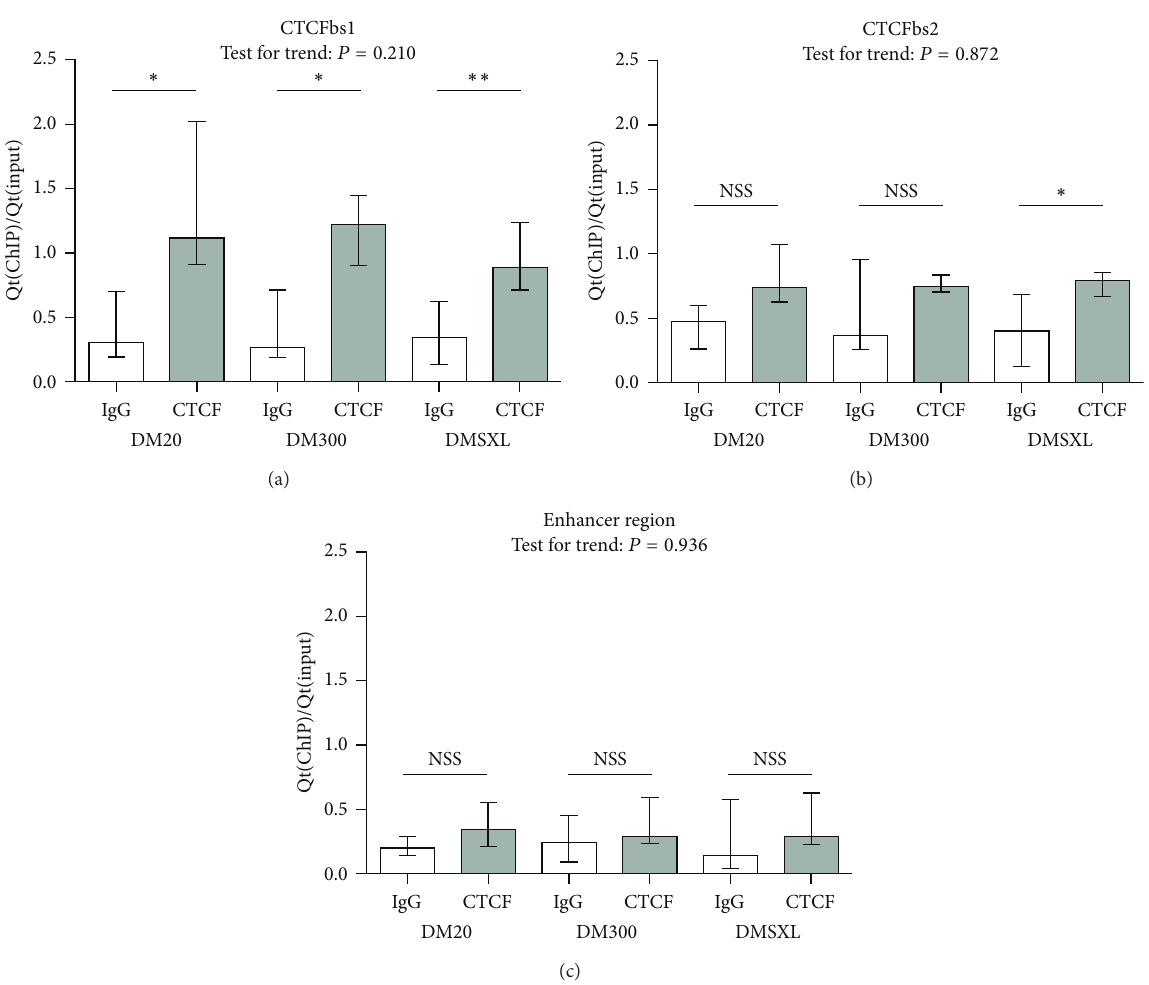
Figure 3: CTCF binds to CTCFbs1, also in the presence of expanded CTG-repeats. These graphs show enrichment ((Qt(IP)/Qt(input), normalised against the abChIP enrichment value of the positive control amplicon of each respective repeat length category) for CTCF in abChIP versus IgG-IP at three regions at the DM1 locus. CTCFbs1 shows statistically significant enrichment for CTCF in abChIP versus IgG- IP in all repeat length categories. No such CTCF-binding is seen at CTCFbs2 or at the enhancer region. Height of the bars indicates median enrichment; error bars indicate the interquartile range (25th to 75th percentile of observations). Mann-Whitney tests were performed to test for a statistically significant difference between the abChIP and IgG reactions. Results are summarised here with ∗ being 𝑃 < 0.05 , ∗∗ being 𝑃 < 0.01 , and ∗∗∗ being 𝑃 < 0.001 . Details of the statistical analysis can be found in Supplementary Table 1. Enrichment values obtained for abChIP reactions were subjected to the Jonckheere Terpstra test for trend, which tests whether a trend exists across the categories with increasing CTG-repeat length. 𝑃 values are indicated in the graphs and details of this statistical analysis can be found in